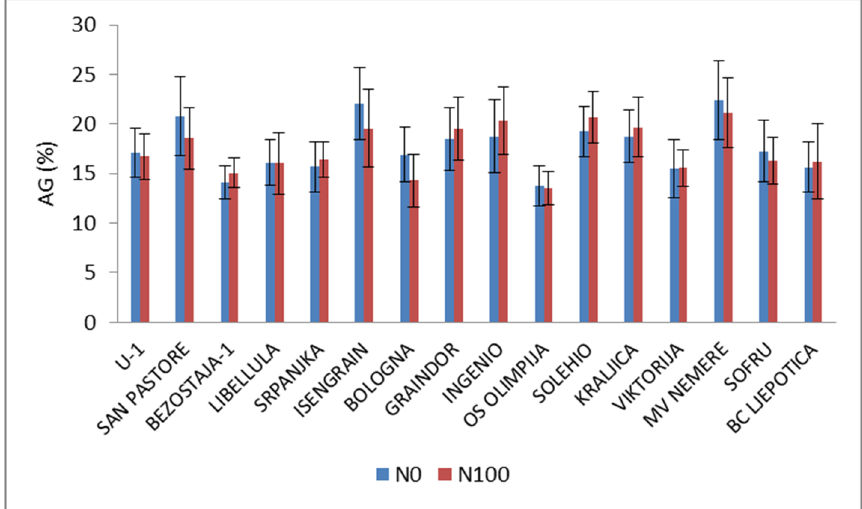
Figure 1. Proportions of albumins and globulins (AG) in total wheat grain protein under low (N0) and high (N100) N levels. (Histograms are showing mean values ± standard deviation across years and locations).